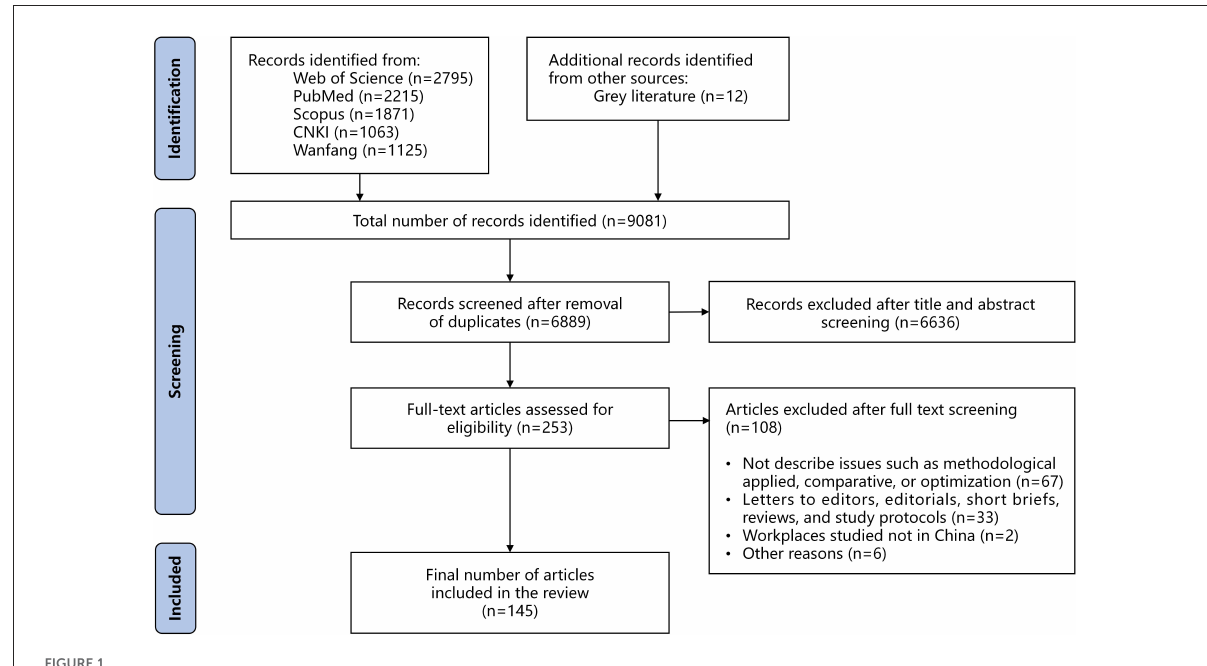
FIGURE1 The PRISMA flowchart of this scoping